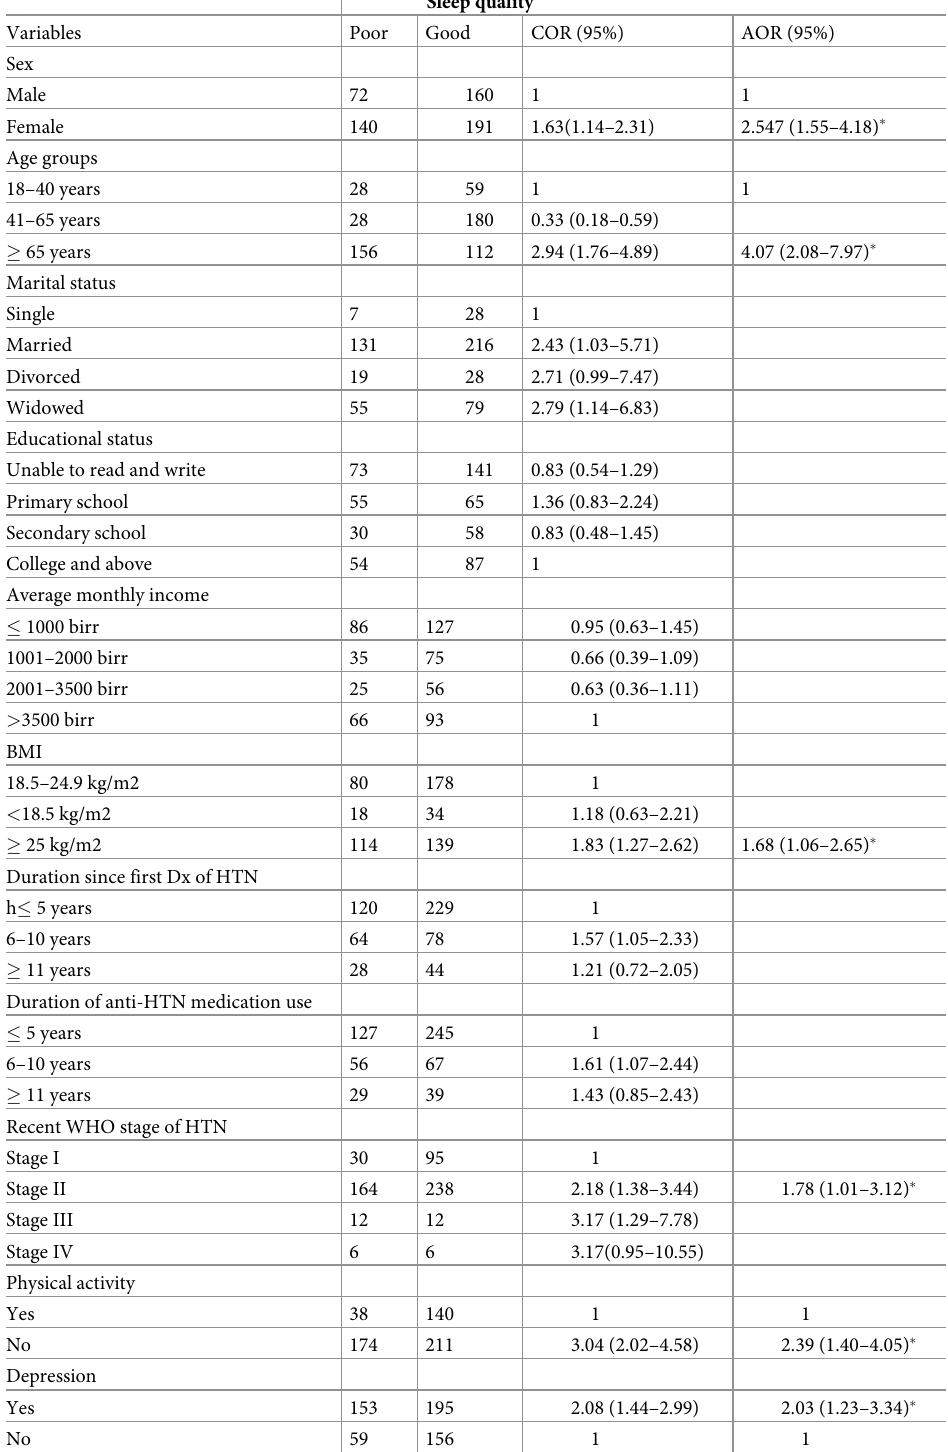
Table 5. Bivariable and Multivariable logistic regression analysis among adult HTN patients at chronic follow-up care clinic in northwest Amhara regional state referral hospitals, Northwest Ethiopia, 2021 (n =